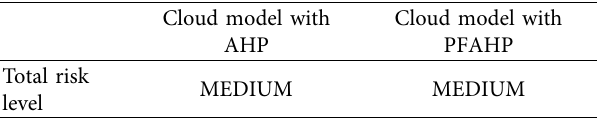
Table 11: Comparison of the AHP cloud model and the PFAHP cloud model: